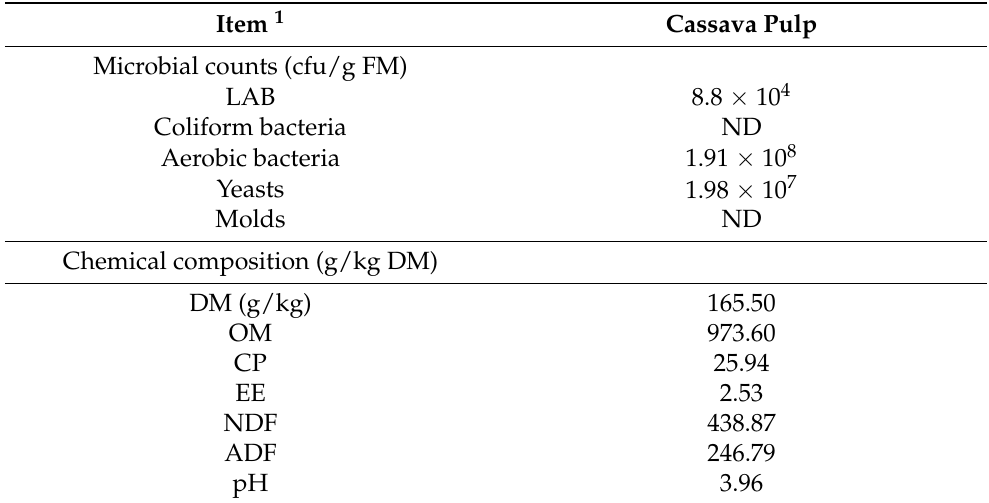
Table 1. Microbial counts, chemical composition, and pH of wet cassava pulp before fermentation. Item